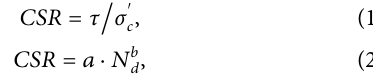
Frontiers in Earth Science |